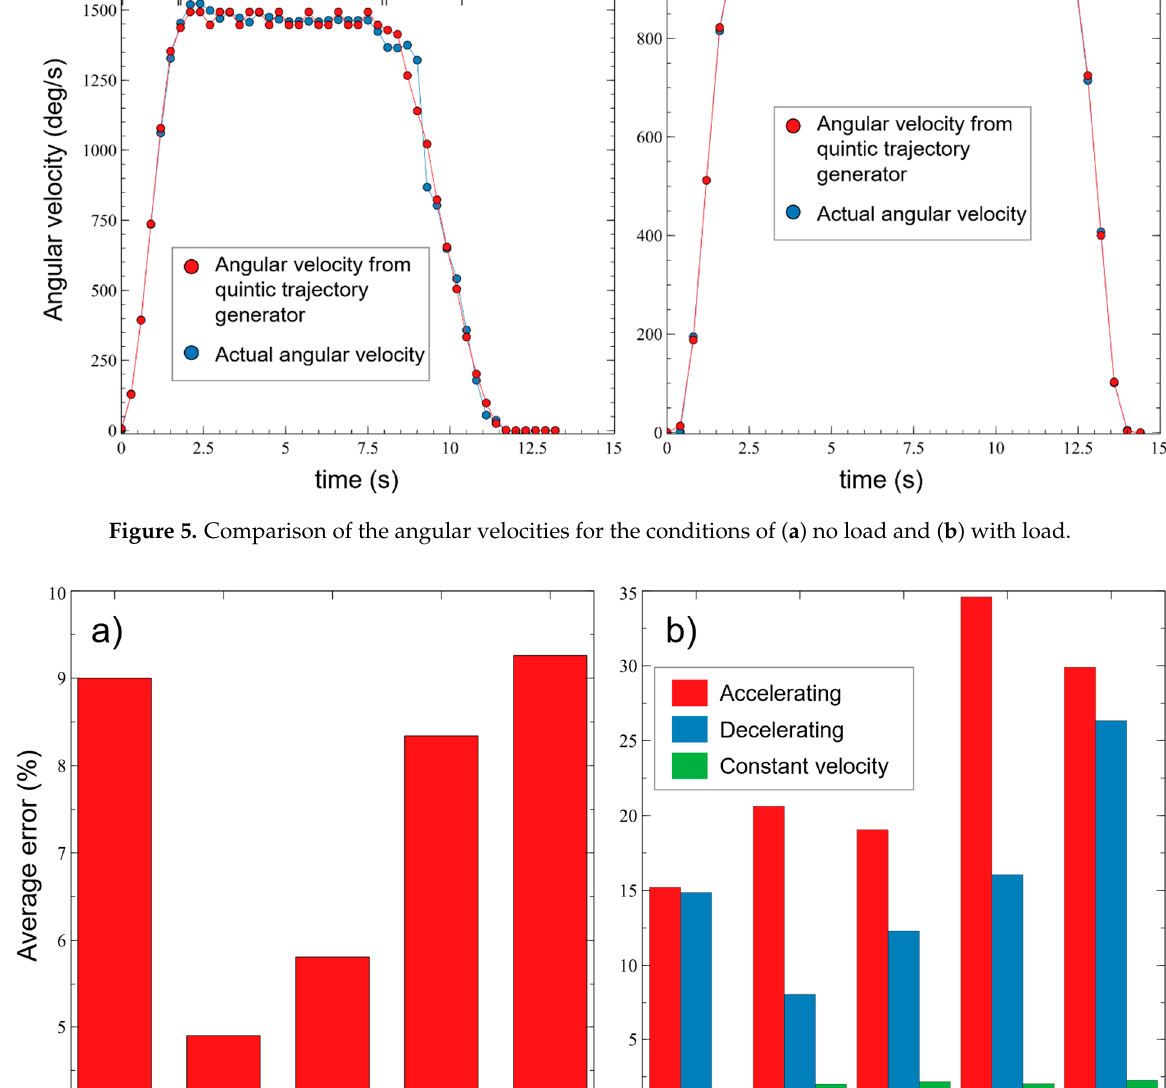
Figure 5. Comparison of the angular velocities for the conditions of ( a ) no load and ( b ) with load.